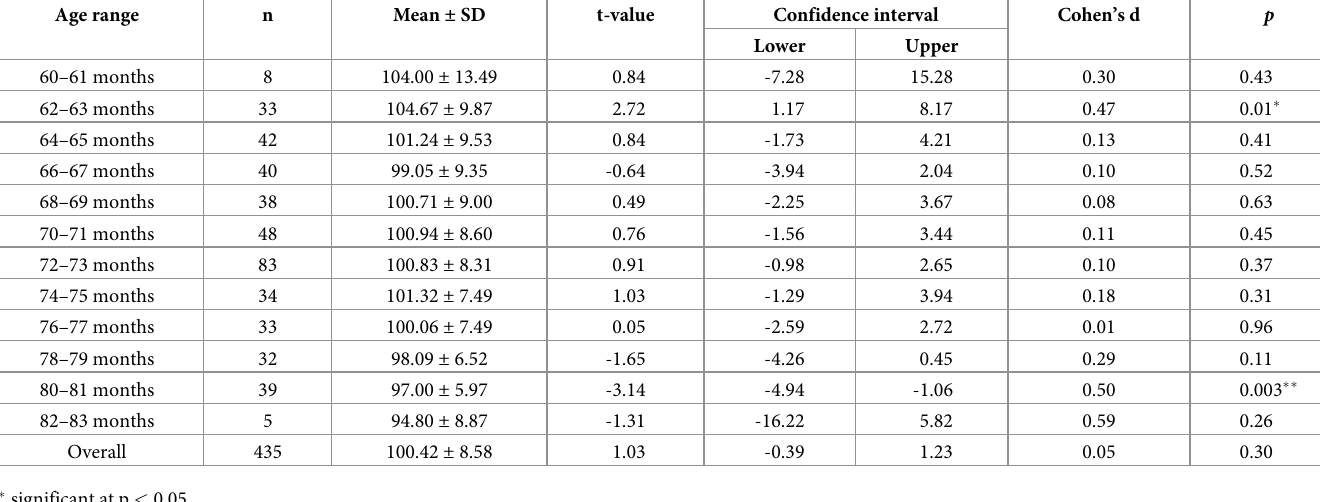
Table 3. Comparison of the Beery-VMI score between Malaysian and US samples (mean = 100, SD = 15). Age range